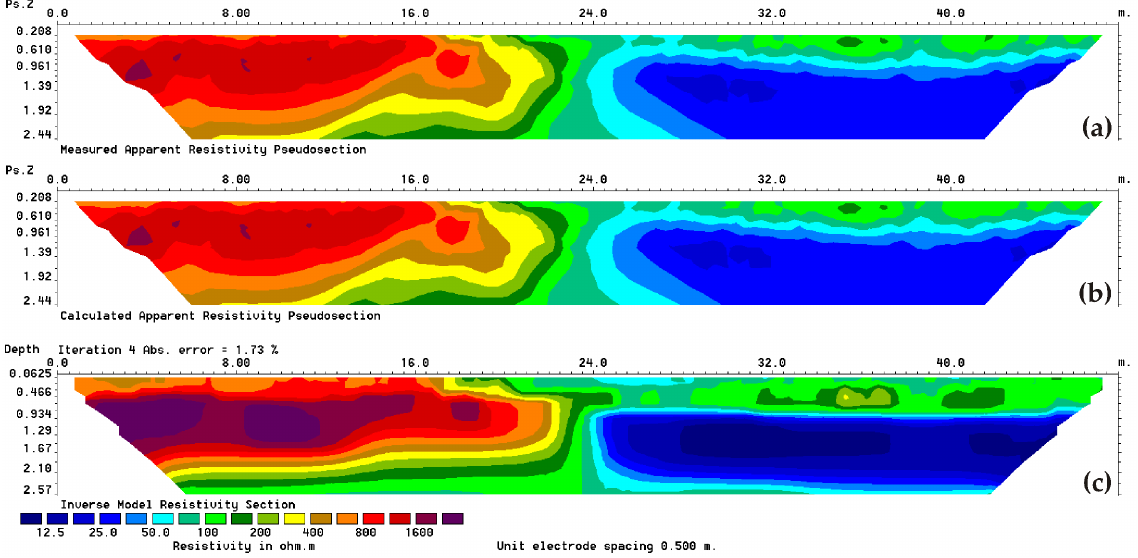
Figure 5. Profile 1 measured ( a ) and calculated ( b ) apparent resistivity sections plus the model resistivity section ( c ).